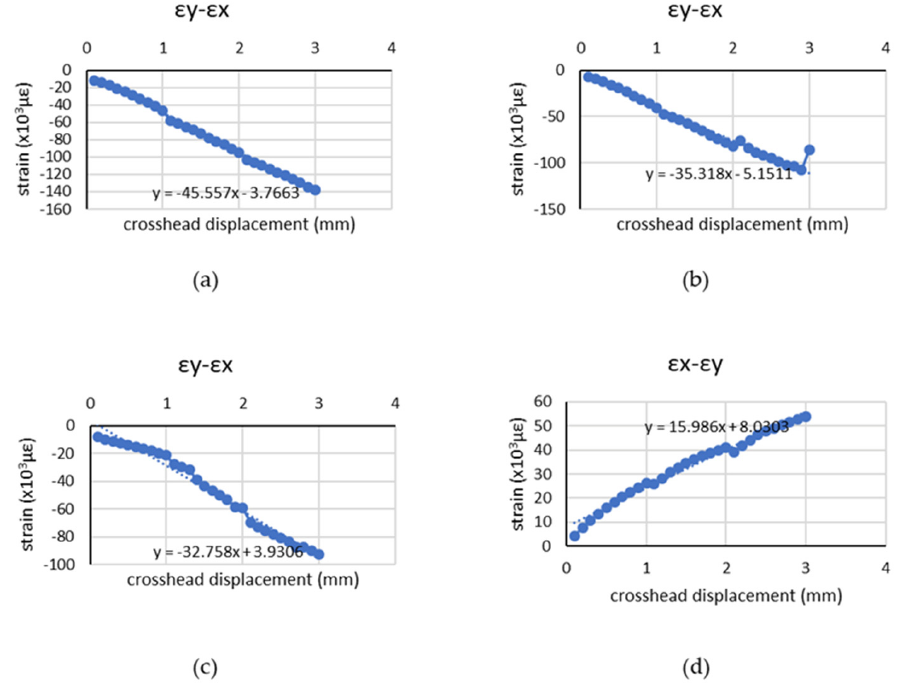
Figure 16. Axial and transverse strain subtracted linear fitting of biological tissue tensile experiment for ( a ) the first slice, ( b ) the second slice, ( c ) the third slice, and ( d ) the fourth slice.